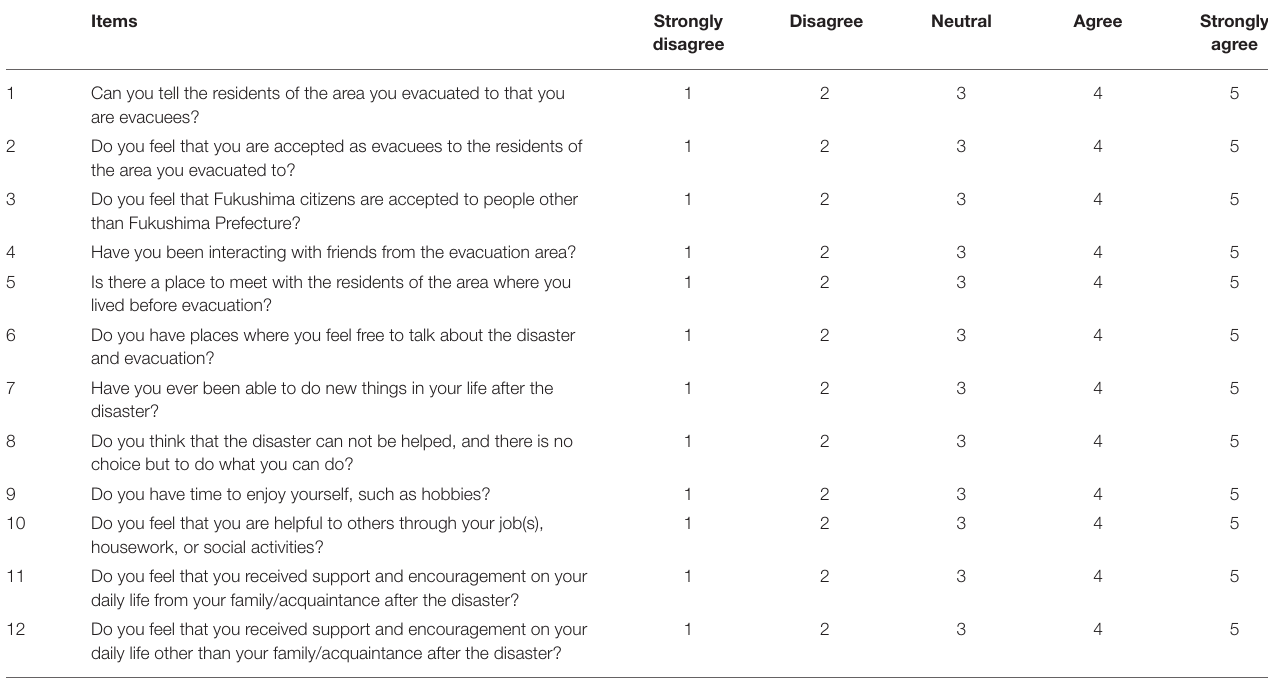
TABLE 1 | The items of the Fukushima Resilience Scale (FRS). Items Strongly